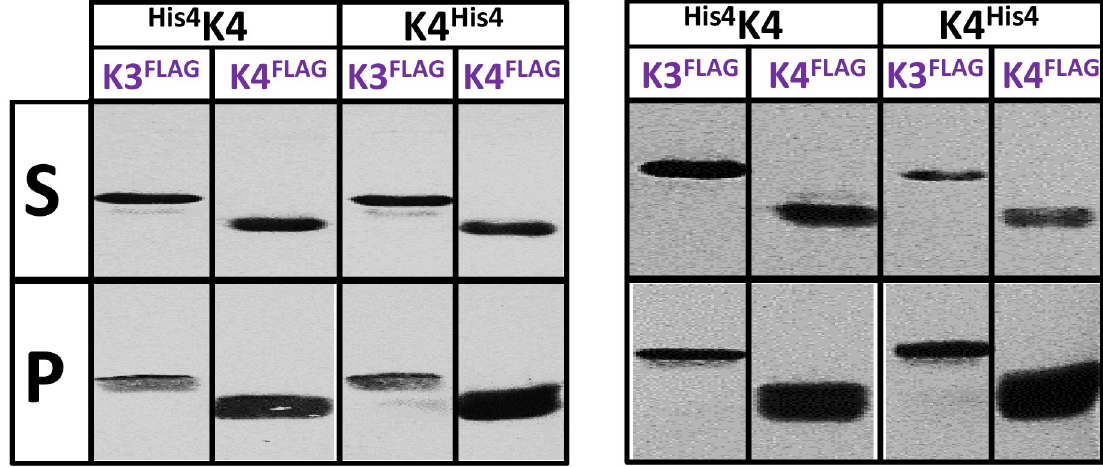
Fig 7. Hetero-hexamer formation between Syn7942 CcmK3 and CcmK4. Western blot analysis of fractions remaining soluble after cellular lysis and centrifugation (top lane) and material purified on TALON resins (bottom). Left panel correspond to samples prepared from cellular cultures that were induced in IPTG (200 μ M), whereas data on the right correspond to samples produced under auto- induction conditions. Detection on PVDC membranes was performed with a mouse antiFLAG primary antibody followed by a secondary IgG antimouse-alkaline phosphatase fusion. Two raw data images were spliced and rearranged to prepare this figure.